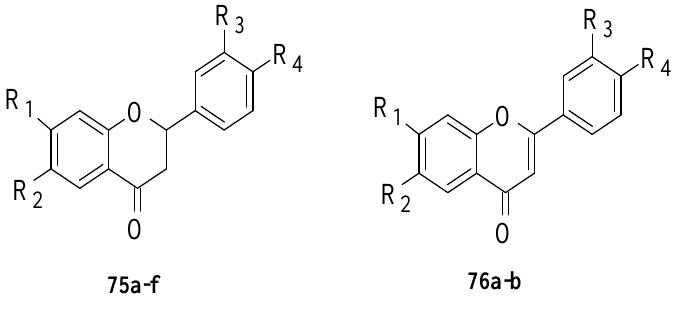
75a R = H, R = Isopentenyl, R = H, R = OH 1 2 3 4 = Isopentenyl, R = H, R = OH 2 3 4 75b R = OMe, R = Isopentenyl, R = OH, R = OH 1 2 3 4 = Isopentenyl, R = OH, R = OH 2 3 4 75c R = OMe, R = Isopentenyl, R = F, R = OH 76b R = OMe, R 1 2 3 4 1 = Isopentenyl, R = F, R = OH 2 3 4 75d R = OMe, R = Isopentyl, R = H, R = OH 1 2 3 4 = Isopentyl, R = H, R = OH 2 3 4 75e R = OMe, R = Geranyl, R = H, R = OH 1 2 3 4 = Geranyl, R = H, R = OH 2 3 4 75f R = OMe, R = H, R = H, R = OH 1 2 3 4 = H, R = H, R = OH 2 3 4 Figure 26. The chemical structures of studied flavonoids for PPAR- γ activation [62].